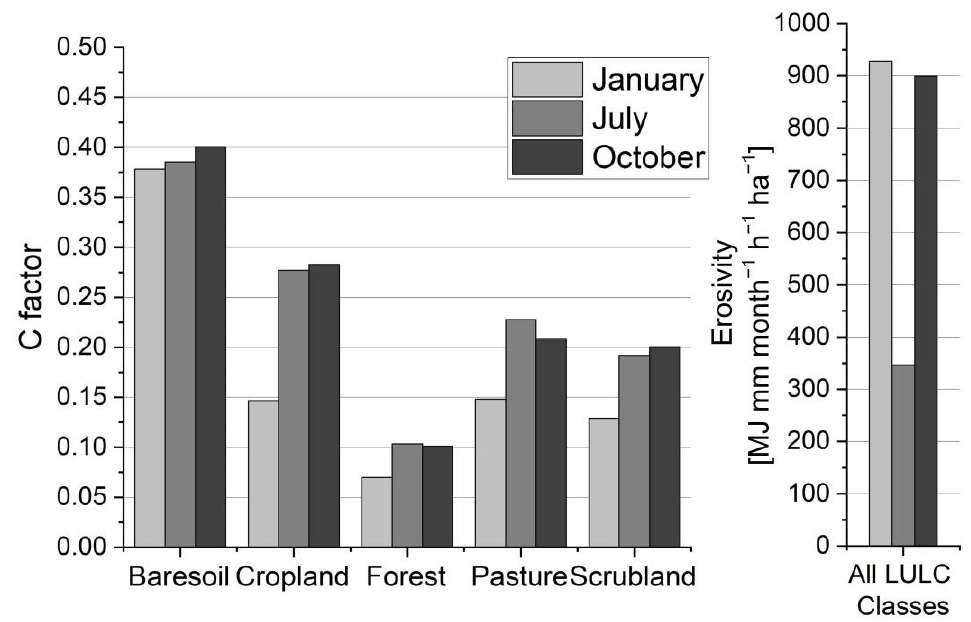
Figure 26. C Factor and R Factor for three months (January, July, October).